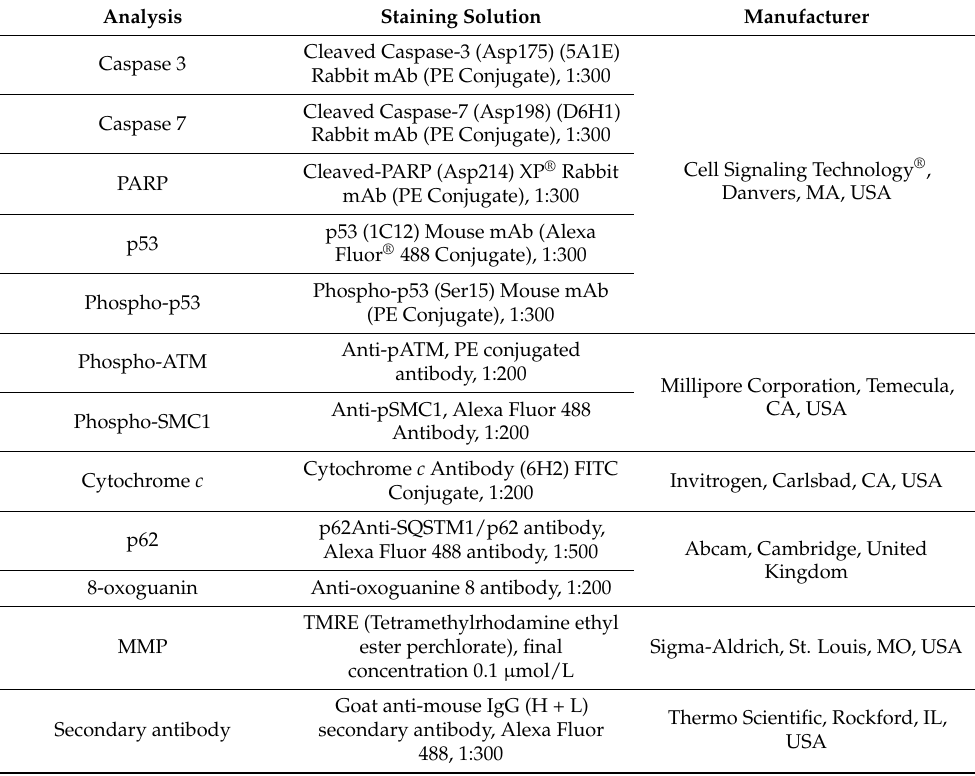
Table 1. List of flow cytometric antibodies and stating solutions.